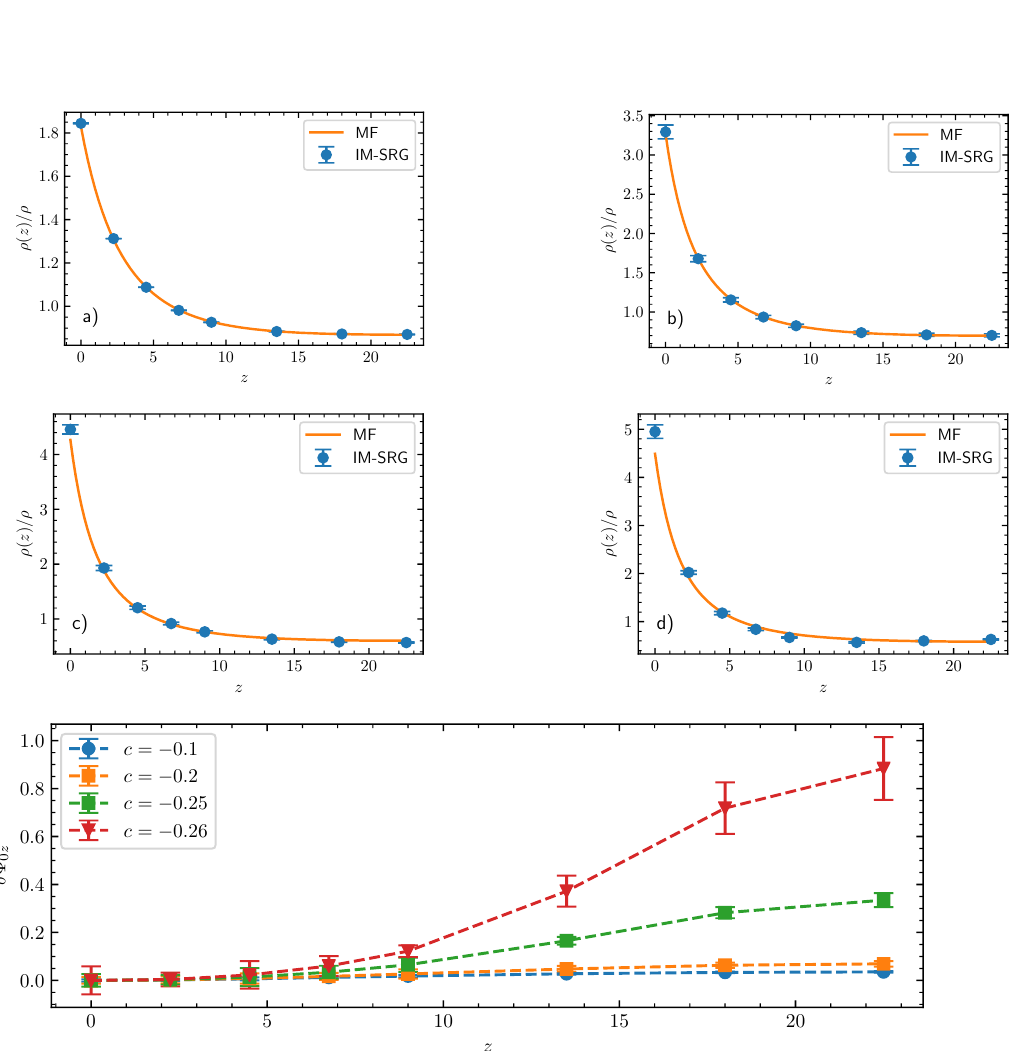
Figure 15: Density of the Bose gas for a heavy attractive impurity ( m → ∞ , c < 0). Blue dots are calculated with the IM-SRG method. The mean-field density is shown as a solid orange curve. The data are for N = 45, γ = 0.02 and a): c = − 0.1, b): c = − 0.2, c): c = − 0.25, d): c = − 0.26. Panel e) shows the corresponding phase fluctuations. Dots with error bars are calculated using the IM-SRG method. The dashed curves are added to guide the